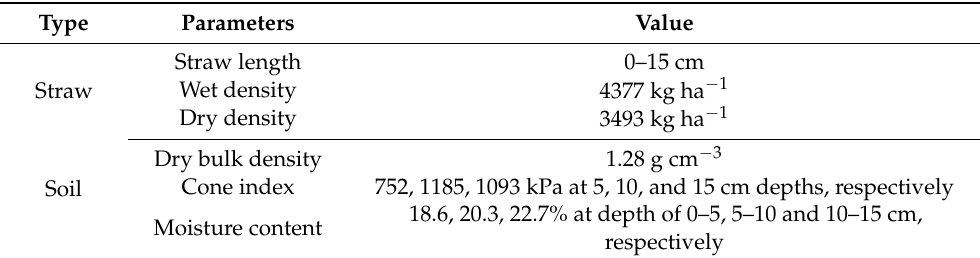
Table 1. Soil and straw parameters of the test